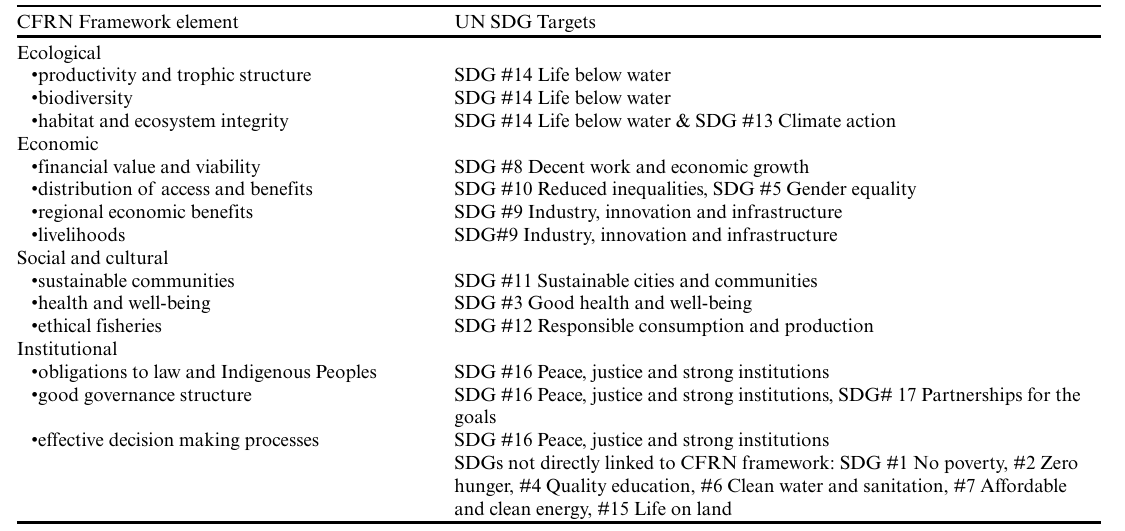
Table 1 . Comparison of elements of the Canadian Fisheries Research Network (CFRN) framework for comprehensive evaluation of sustainable fisheries with major targets of the UN Sustainable Development Goals